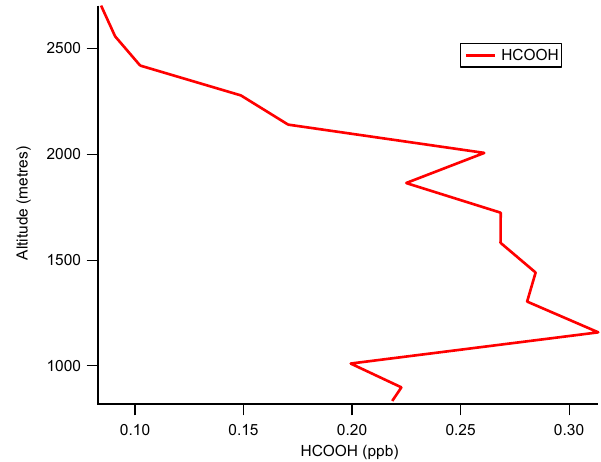
Fig. 8. Vertical profiles of formic acid and NO x mixing ratios from an altitude of 800 to